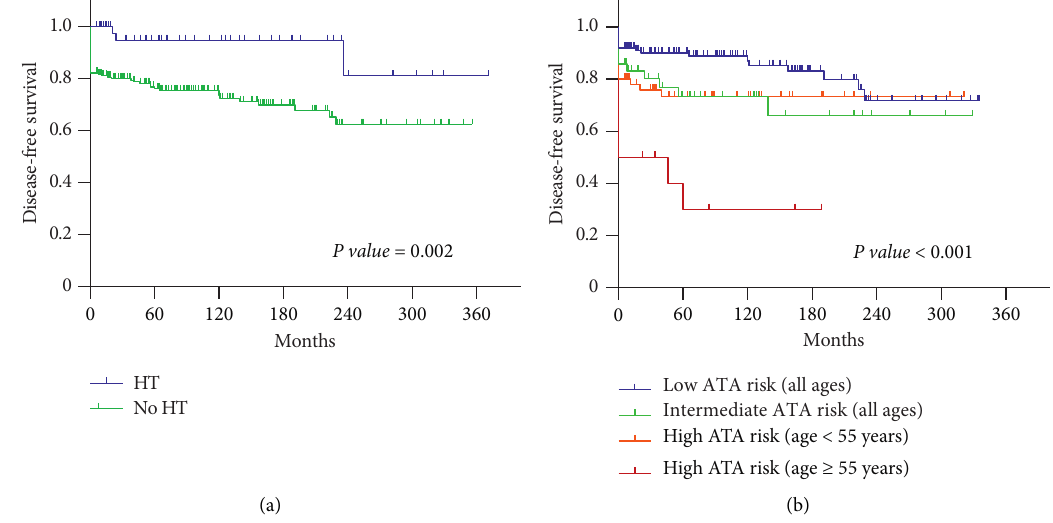
Figure 3: Disease-free survival curves of patients with papillary thyroid cancer based on the following classifications: (a) coexistence of Hashimoto’s thyroiditis (HT); (b) ATA risk